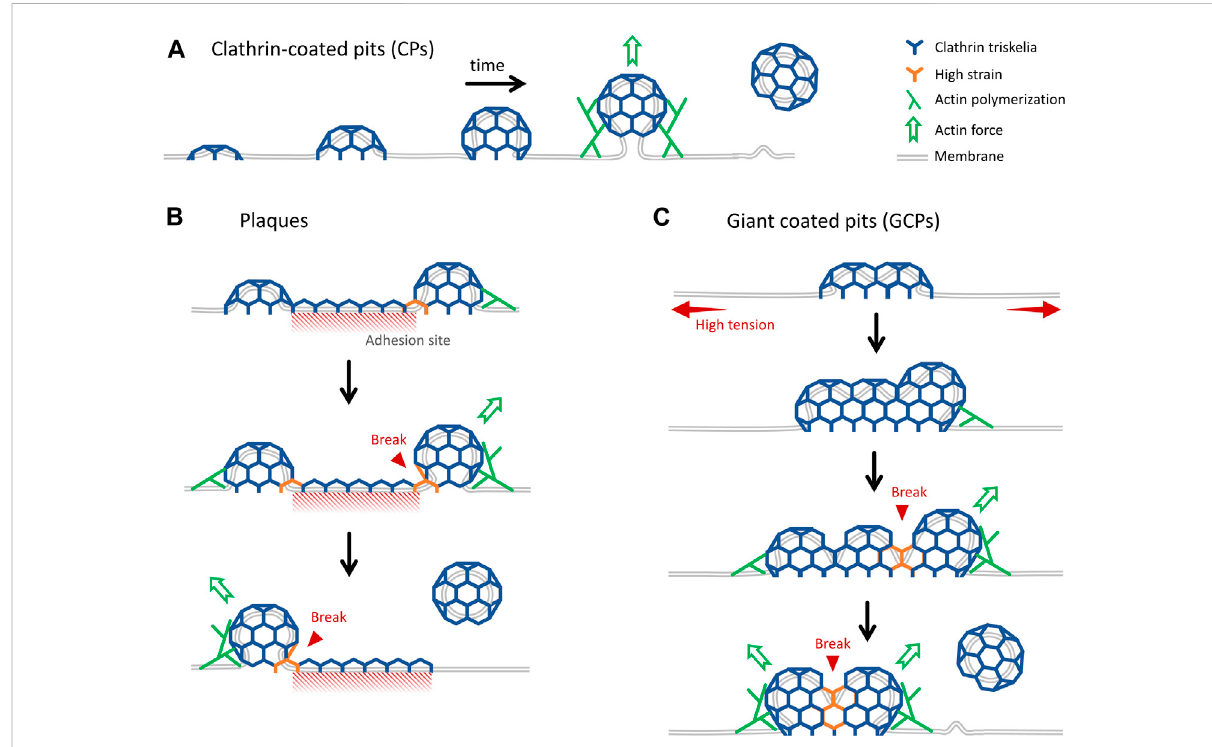
FIGURE 6 Distinct mechanisms of internalization of endocytic clathrin-coated vesicles. (A) Cartoon representation of growth and internalization of canonical CPs. The inward movement of the pit during internalization is dependent on actin dynamics, which becomes indispensable under increased membrane tension (Boulant et al., 2011; Ferguson et al., 2017). (B) Clathrin plaques are predominantly observed at the membrane- substrate adhesion sites. It was proposed that clathrin pits can break apart from the edges of plaques and grow into coated vesicles independently. This “ rupture and growth ” model proposes that increased local curvature creates strain on the lattice, giving rise to breaks and splitting coat fragments (den Otter and Briels, 2011; Lampe, Vassilopoulos and Merri fi eld, 2016; Willy et al., 2021b). (C) GCPs form under increased membrane tension. They are larger than CPs, but they impose membrane curvature in a similar way. We propose that forces produced by actin polymerization, aided by reducing plasma membrane tension, give rise to splitting of GCPs into multiple small fragments that are internalized